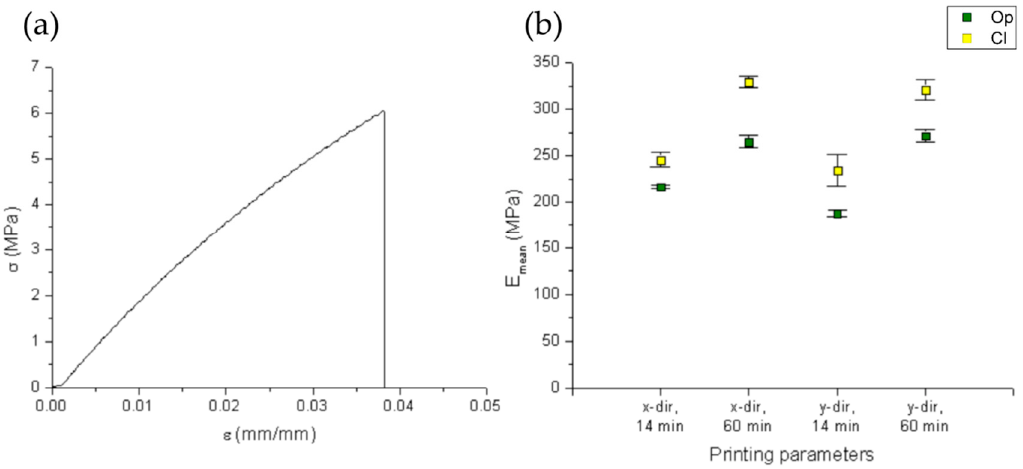
Figure 5. Results from mechanical characterization. ( a ) Typical stress-strain curve for the tested samples (here the one relative to sample #4). ( b ) Plot of mean values for Young’s modulus.